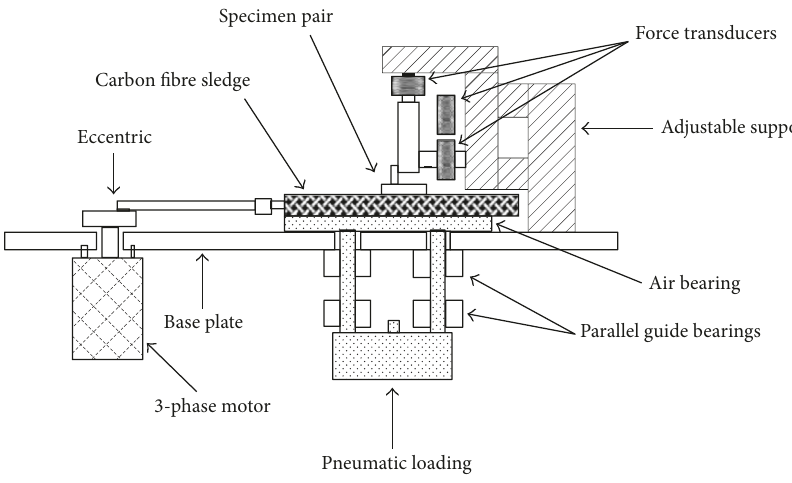
Figure 2: Schematic overview of the reciprocating eccentric